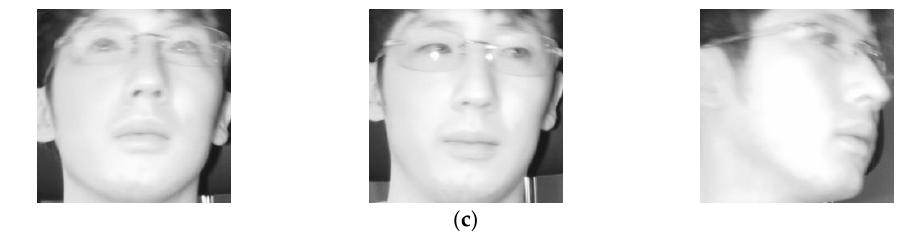
Figure 14. Incorrectly detected gaze zones with our system. Left, middle, and right figures respectively show the cases that the driver looks at gaze zones of ( a ) 1, 7, and 14; ( b ) 15, 2, and 8; ( c ) 9, 3, and 16.